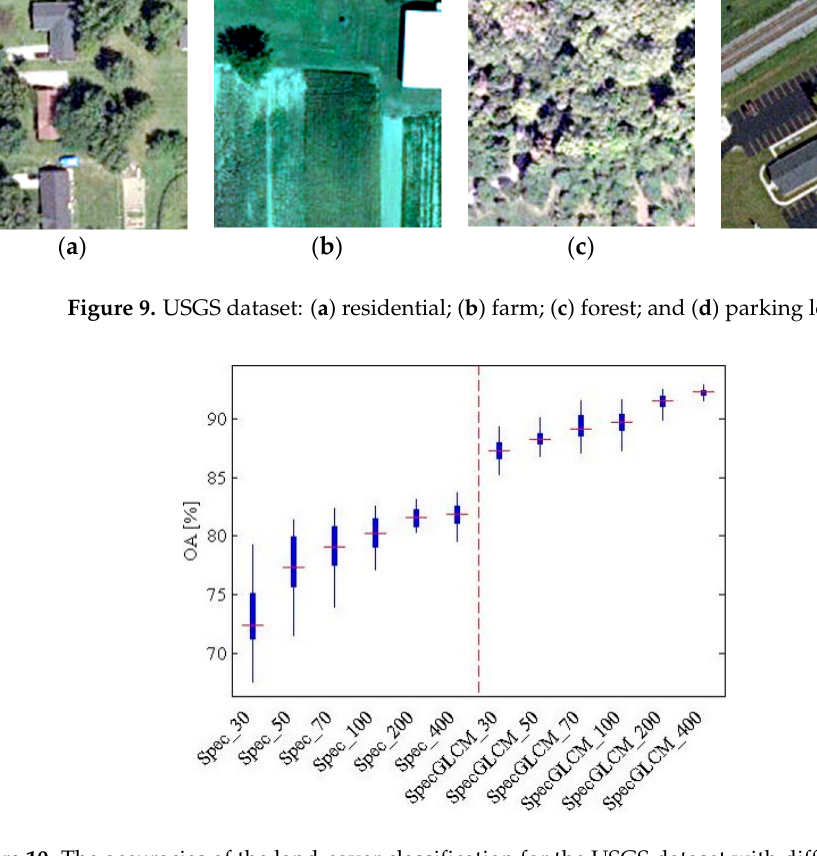
Figure 8. USGS large image and its scene understanding result: ( a ) the original image; and ( b ) the scene understanding result.